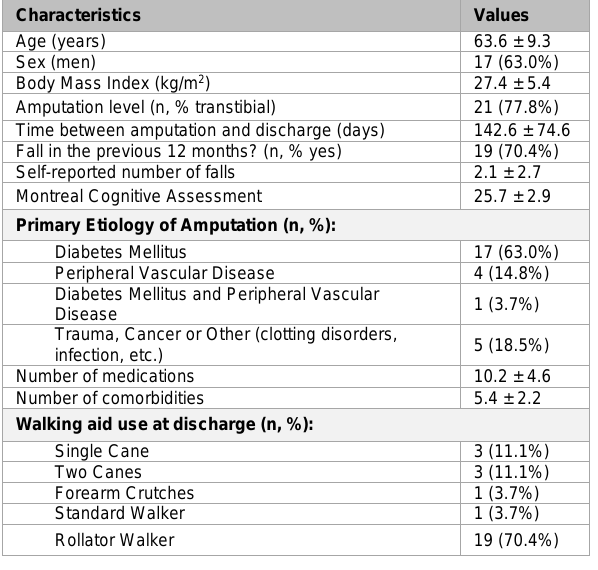
Table 2: Results of objective and subjective measures of walking ability at discharge from prosthetic rehabilitation. ( n=27 ).